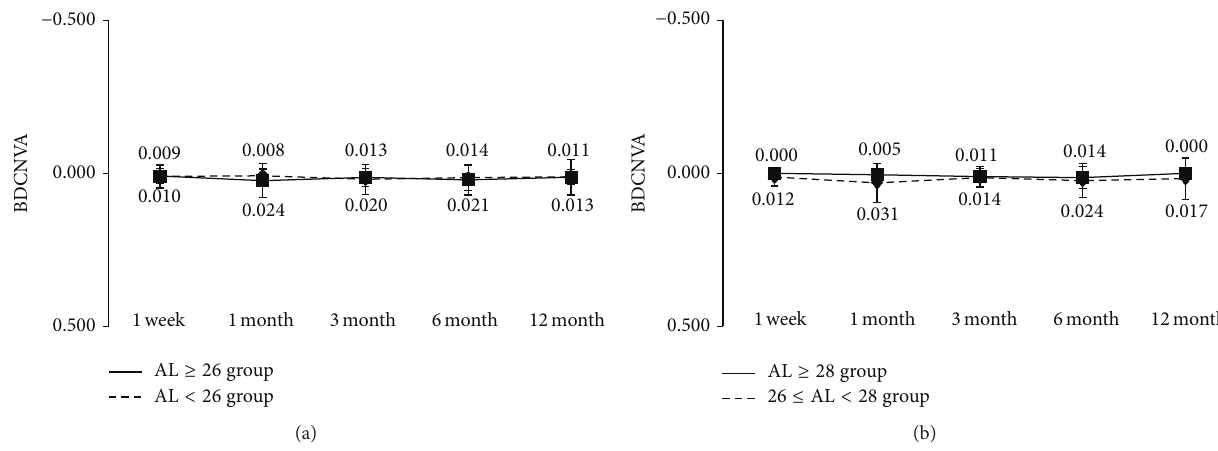
Figure 5: Best distance-corrected near visual acuity during 12-month follow-up after implantation of multifocal intraocular lens. (a) Eyes were divided into axial length of 26 mm or longer (AL ≥ 26 group) and less than 26 mm (AL < 26 group). (b) Eyes in AL ≥ 26 group were further divided into 26 ≤ AL < 28 group and AL ≥ 28 group. ∗ NS Mann-Whitney 𝑈 test.